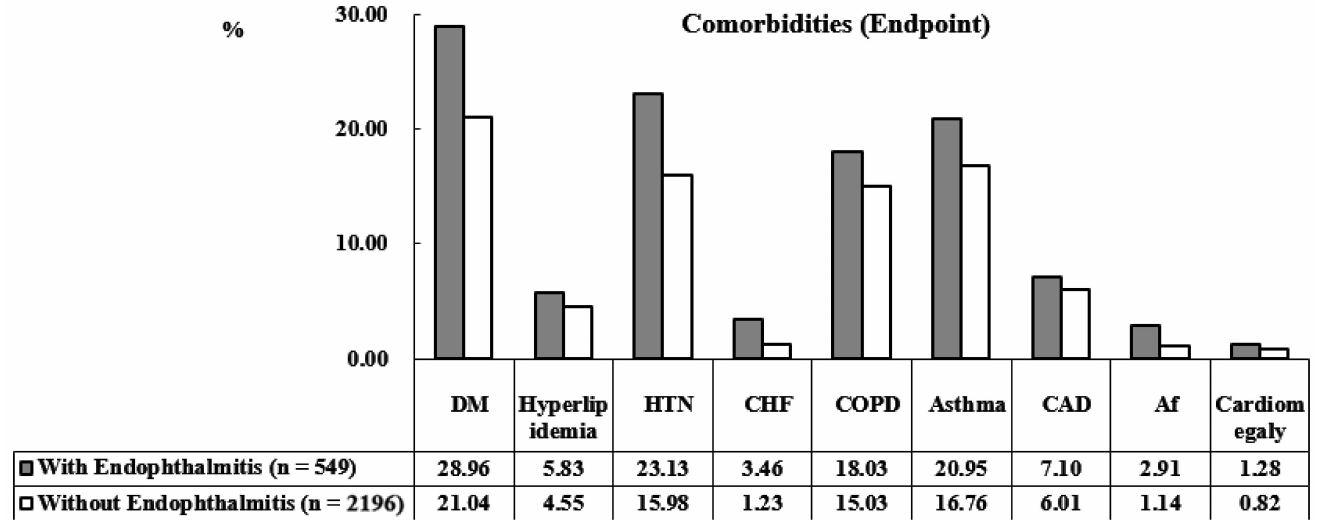
Figure 3. Bar graph of the comorbidities in the study population at study